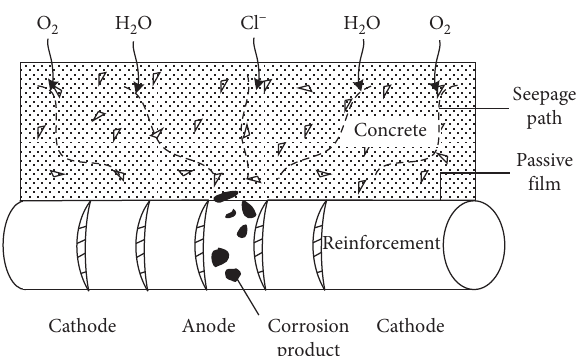
Figure 2: The schematic diagram of the electrochemical principle.